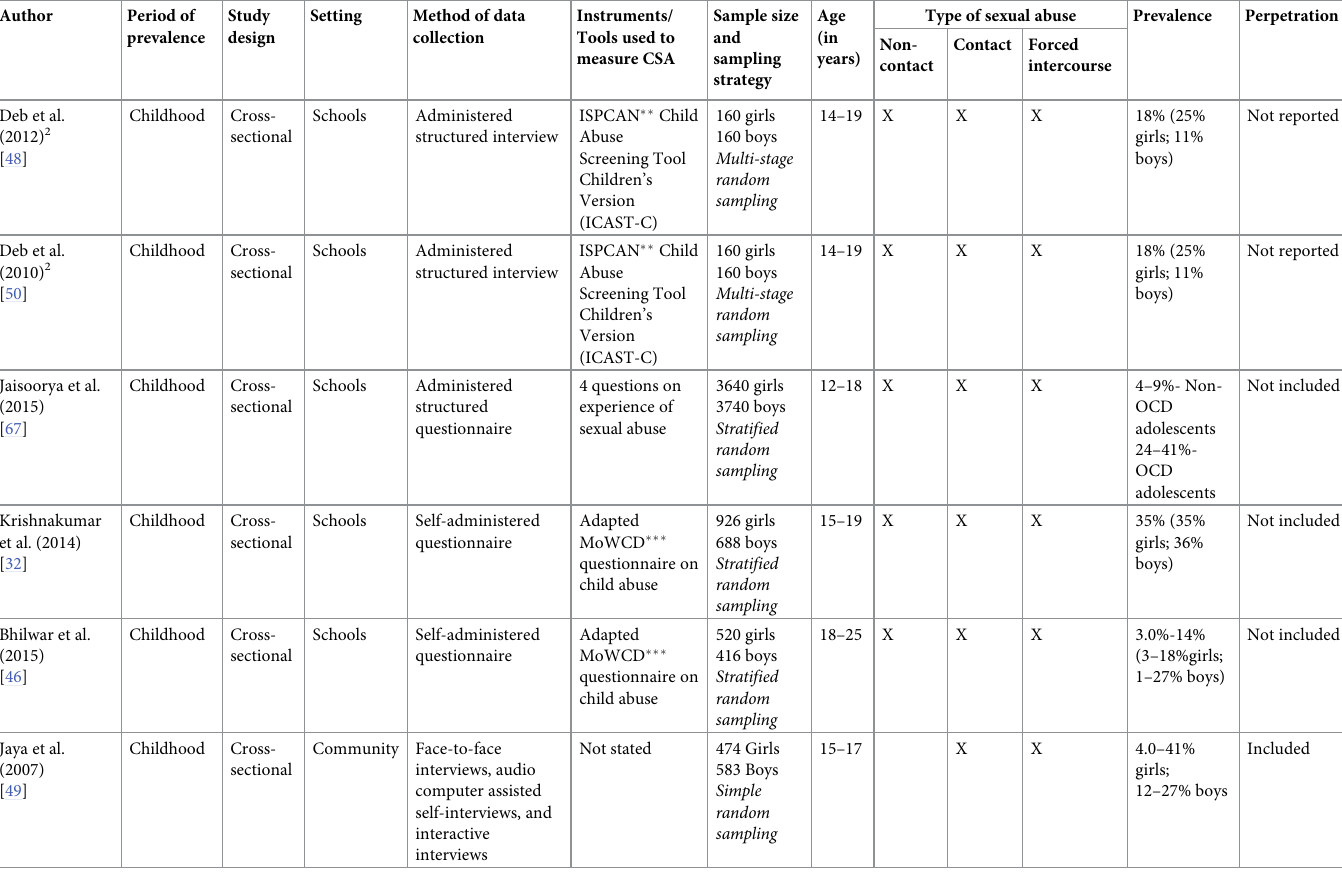
Table 3. Characteristics of quantitative and mixed-method studies included in the review with school/college, clinical, and community